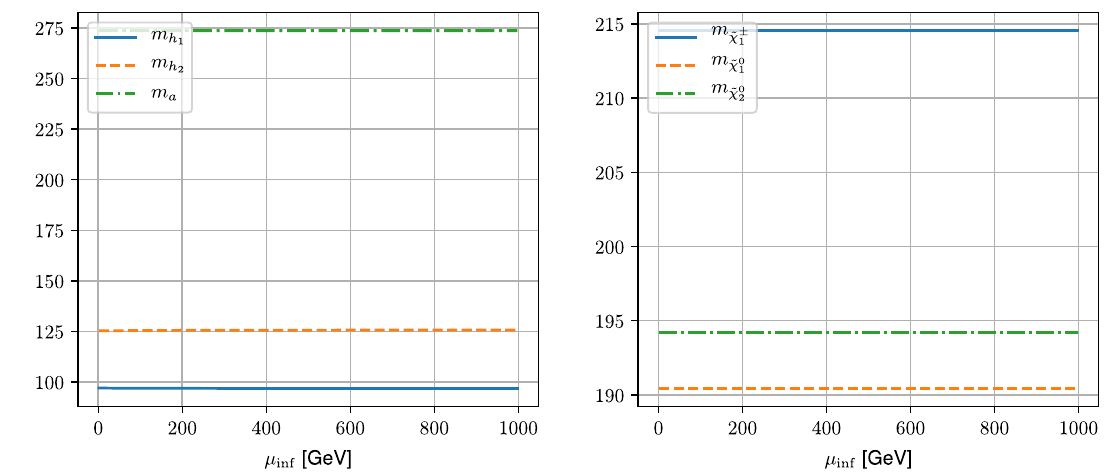
Fig. 6 The masses of the light CP -even states h 1 , h 2 , and the CP -odd singlet-like state a (left); the masses of the light neutralinos ˜ χ 0 light chargino ˜ χ ± (right), depending on the pure μ inf 1